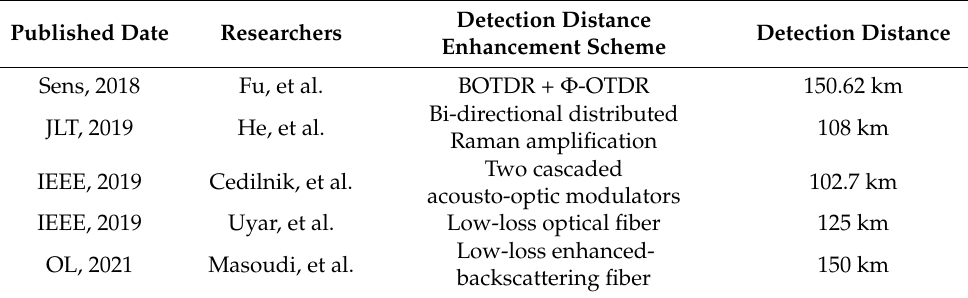
Table 6. Research progress for detection distance enhancement.